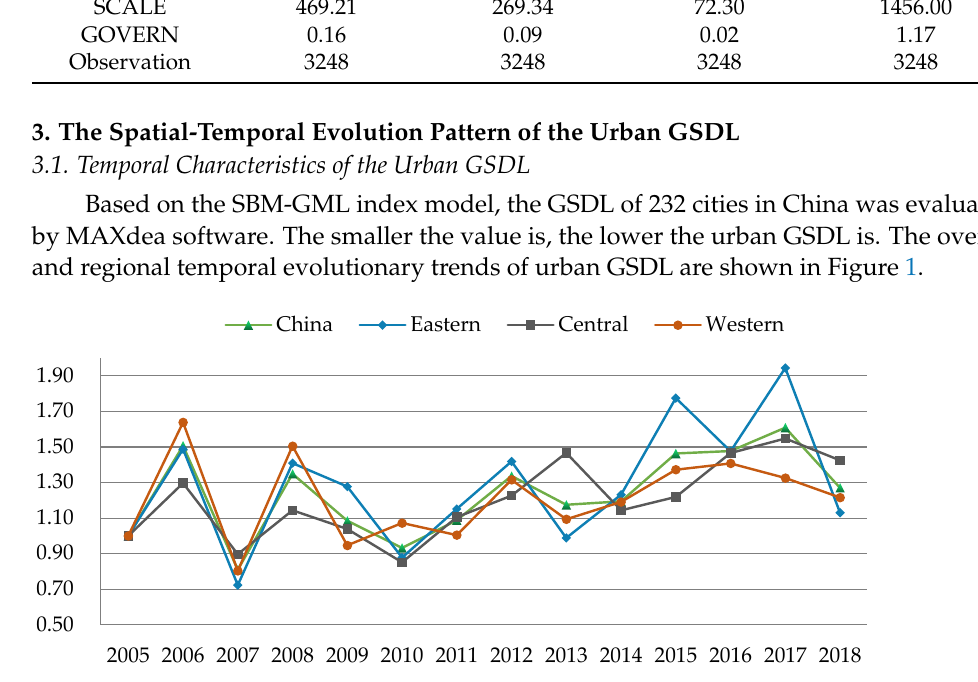
Figure 1. The temporal trend of urban GSDL in China from 2005 to 2018.